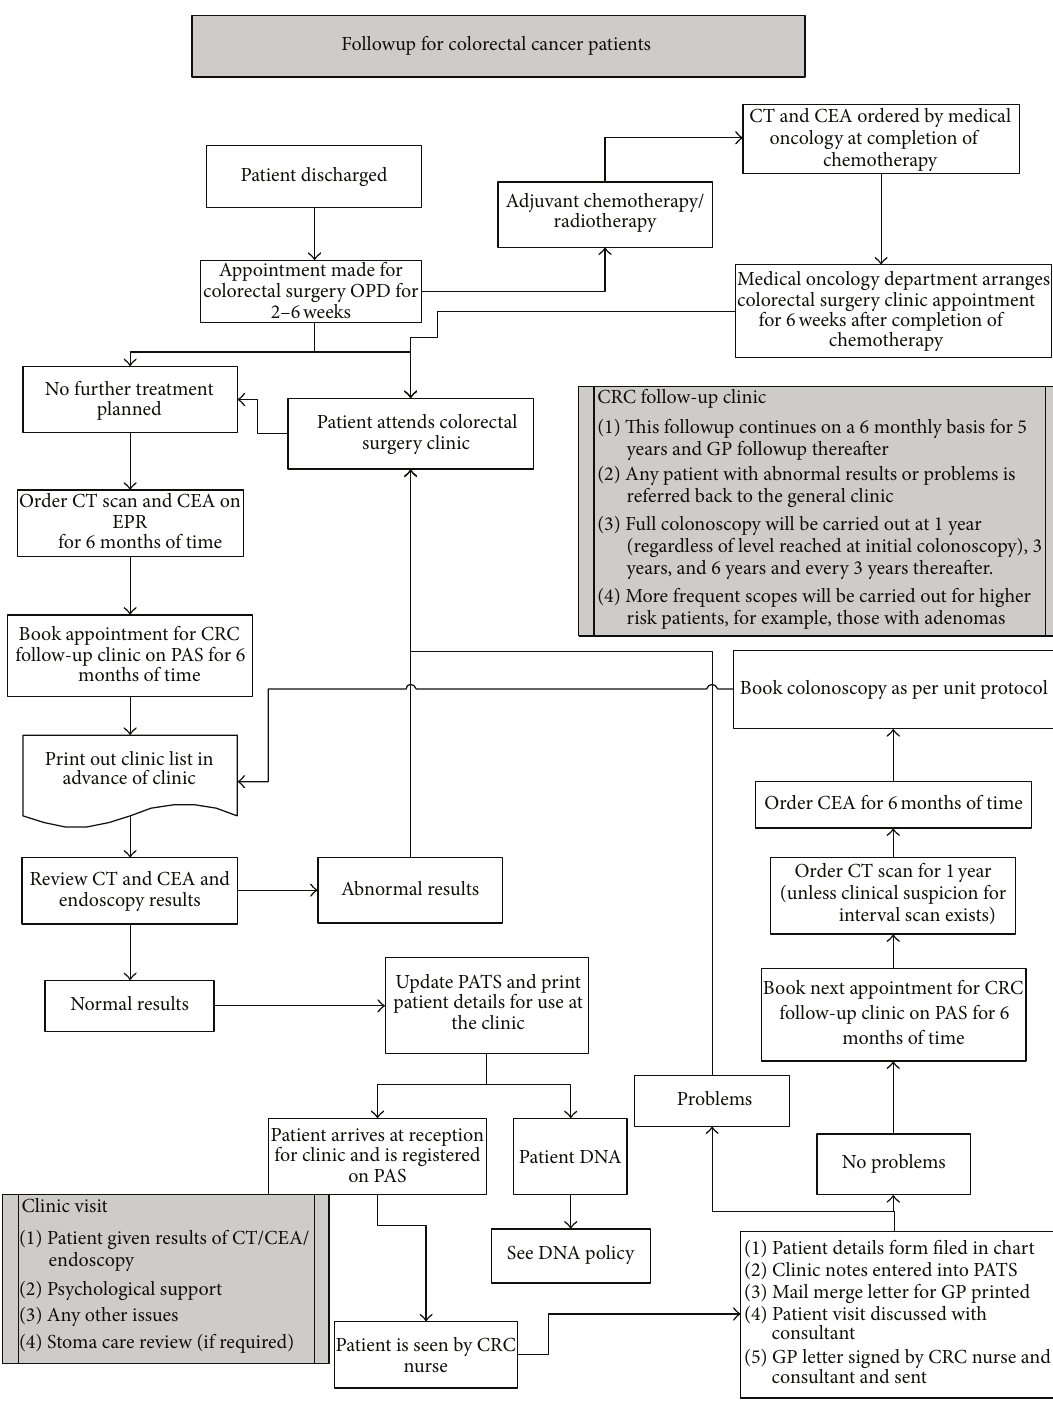
Figure 1: Demonstrates the follow-up protocol in the nurse-led colorectal cancer